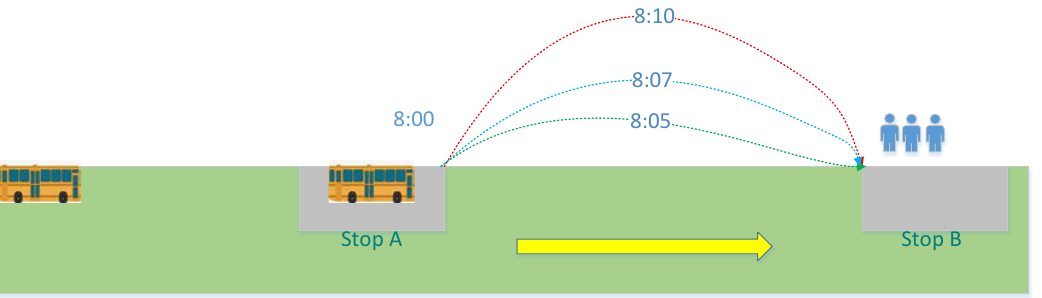
Figure 1. An example of PIs and point prediction for bus travel time.